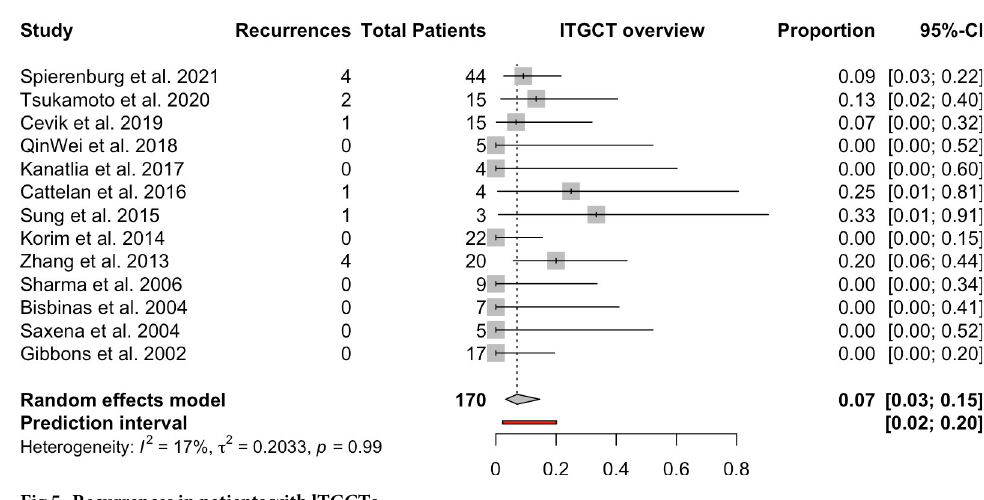
Fig 5. Recurrences in patients with lTGCTs.